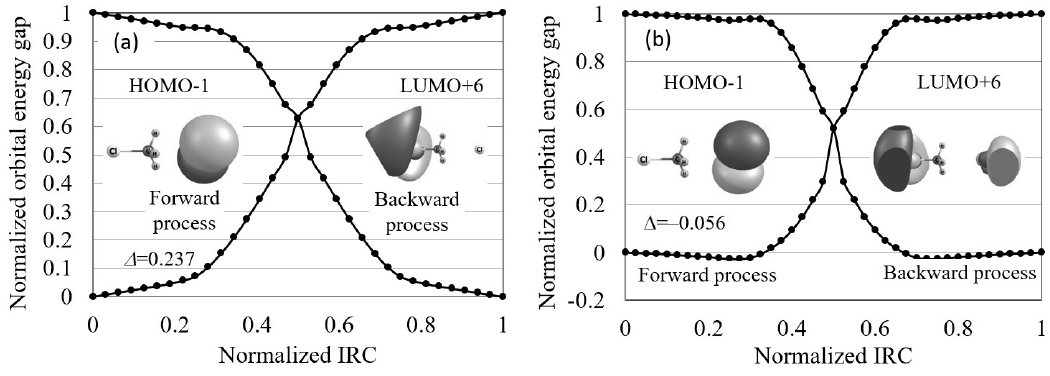
Figure 8. The normalized reaction diagrams of the Cl − ...CH 3 Cl → ClCH 3 ...Cl − reaction in gas phase and in aqueous solution, which are calculated by LC-BLYP/aug-cc-pVTZ. The images of the molecular orbitals mainly contributing to each reaction process and the calculated orbital energy gap gradient values are also